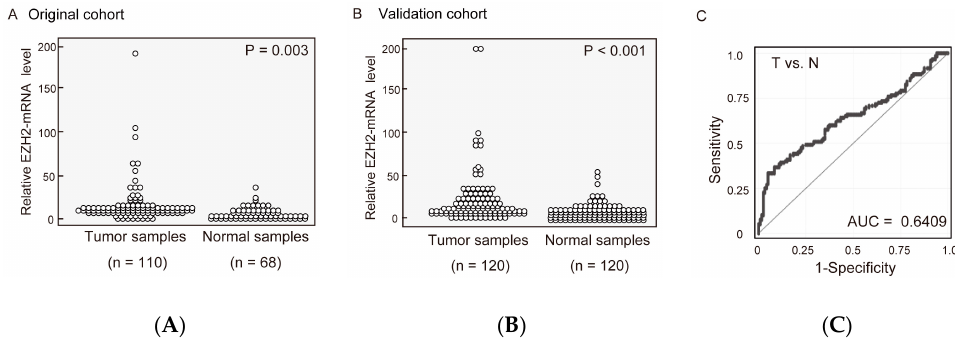
Figure 1. Enhancer of zeste homolog 2 (EZH2) mRNA patterns in matched pairs of head and neck squamous cell carcinoma tissue and adjacent normal mucosal tissues. Relative EZH2 mRNA expression levels in ( A ) the original cohort and ( B ) the validation cohort were analyzed in clinical samples. Changes between cancerous and normal mucosal tissues were considered significant, as determined using the Student's t -test. ( C ) Area under the receiver-operator characteristic (ROC) curve (AUROC) value for EZH2 was 0.6409. At the cutoff value of 17.81, sensitivity was 33.3%; specifically, 95.1%.